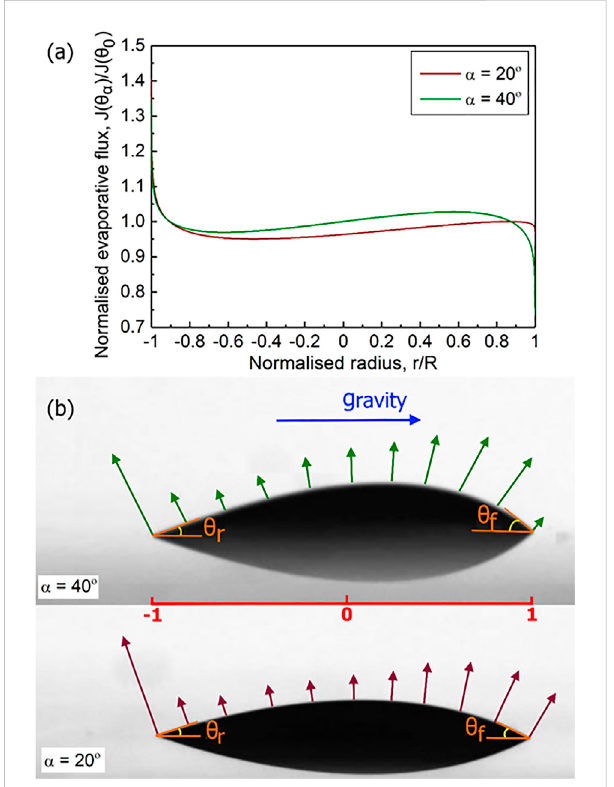
FIGURE 4 (A) Normalised evaporative fl ux of the 0.1% microspheres drops drying at 20 ° and 40 ° inclination versus the normalised radius. (B) Schematic illustration of the distribution of the evaporative fl ux magnitudeattheinclinationsof20 ° and40 ° .Thelengthofarrows corresponds to the calculated evaporative fl ux magnitudes J ( θ 20 ) and J ( θ 40 ) .